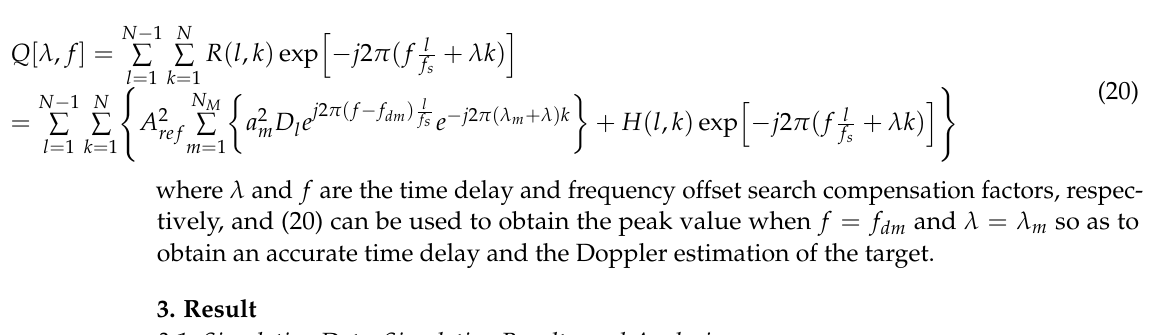
Table 1. Simulation Target Parameter.